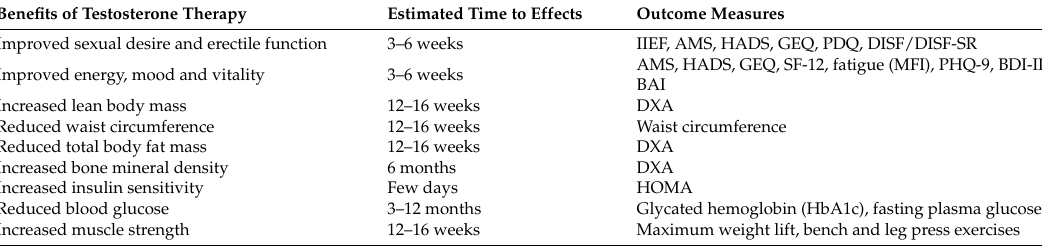
Table 1. Benefits of testosterone therapy and outcome